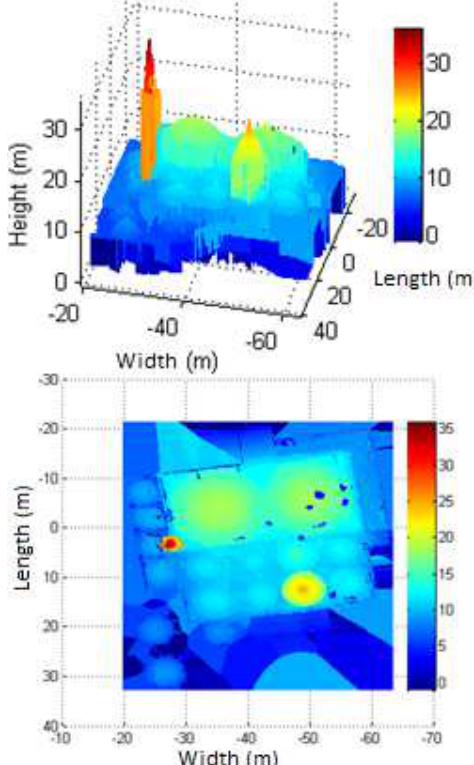
Figure 15. Digital elevation model of Mevlana Museum (units are